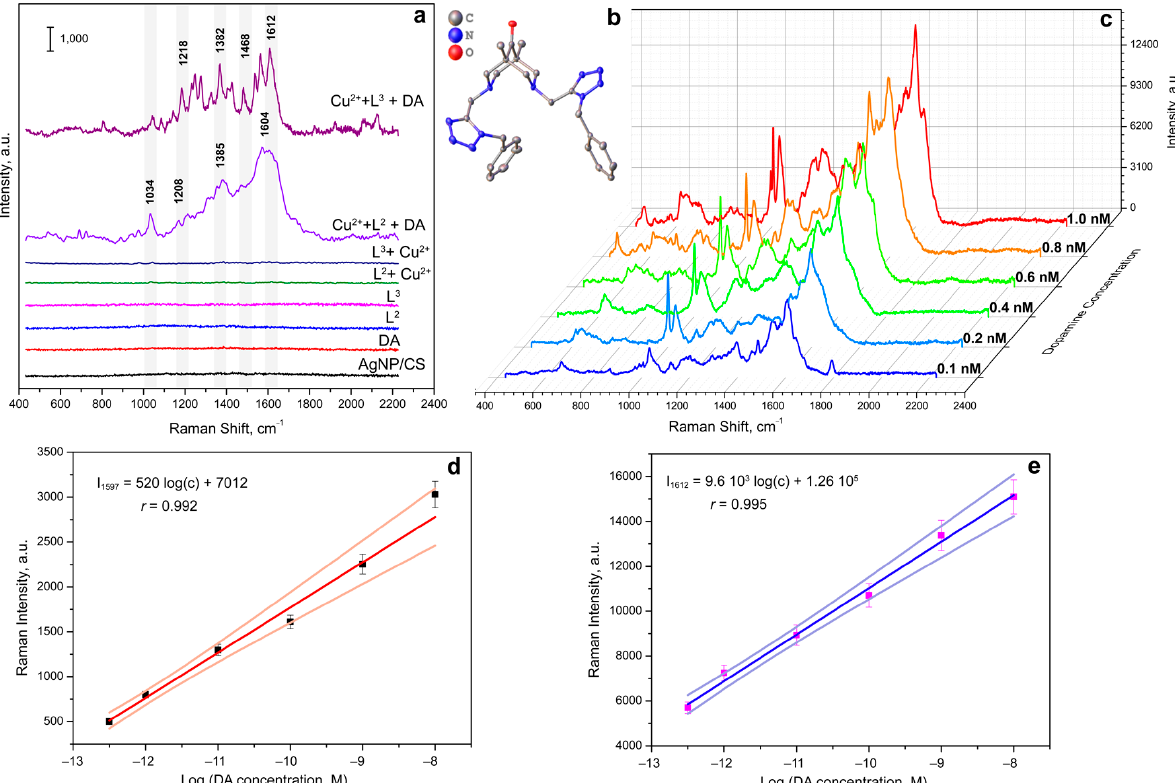
Figure 5. ( a ) Typical SERS spectra of the blank non-modified SERS substrate, DA (0.1 mM), L 2